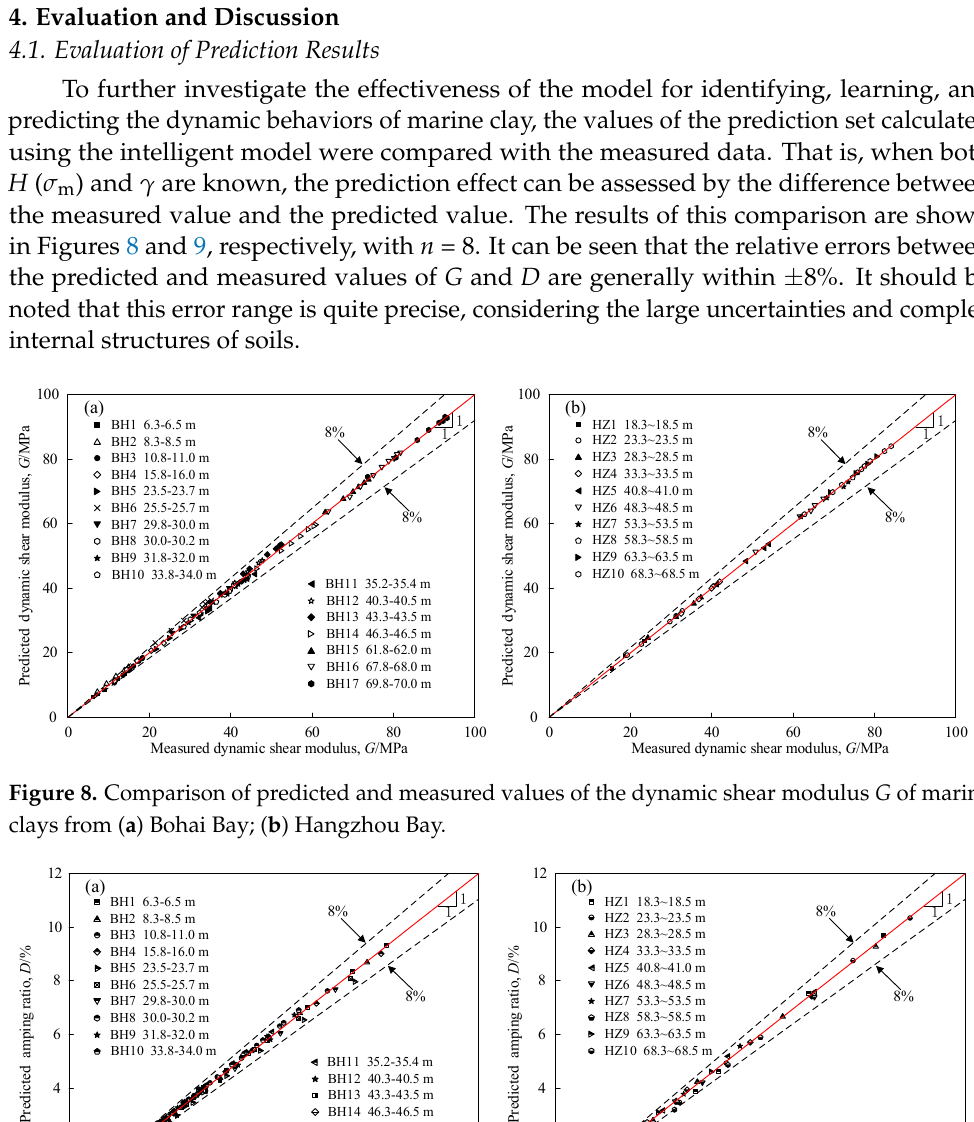
Figure 7. Prediction performance of the intelligent model with different n: ( a – c ) the MAE of G , G / G max , and D for marine clays; ( d – f ) the RMSE of G , G / G max , and D for marine clays; ( g-i ) the R of G , G / G max , and D for marine clays.